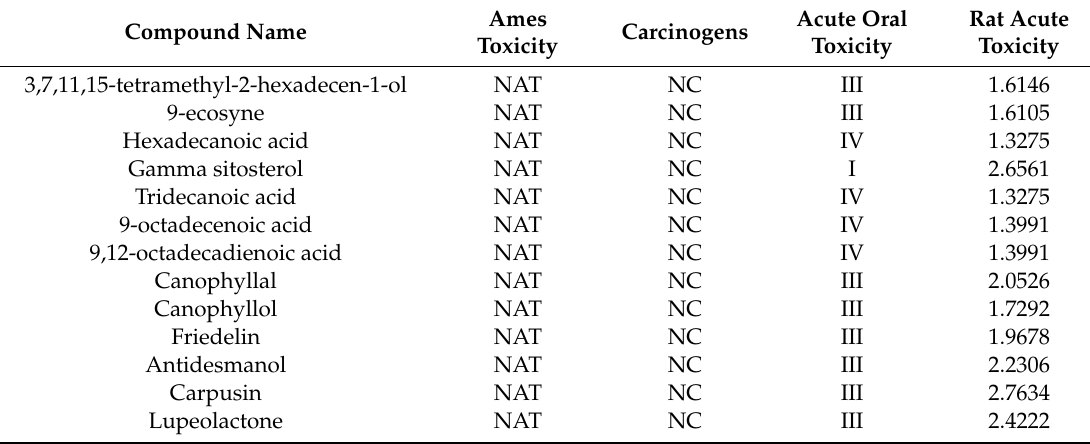
Table 8. Toxicological properties of the selected